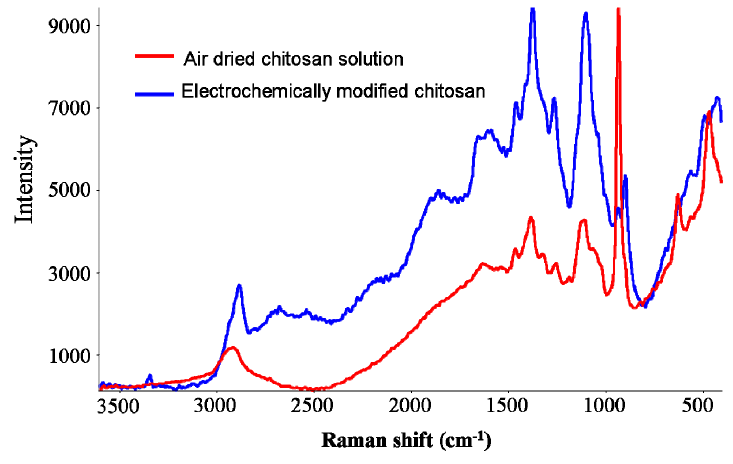
Figure 2. Raman spectra of electrochemically modified chitosan (ECM) chitosan and dried chitosan solution at pH 2.